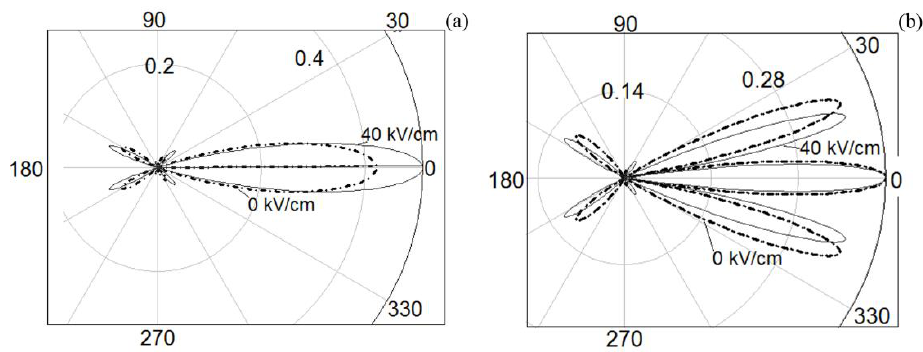
Fig.5. Radiation patterns of the investigated MSA: (a) in plane H ( z 0 x ); (b) in plane E ( z 0 y